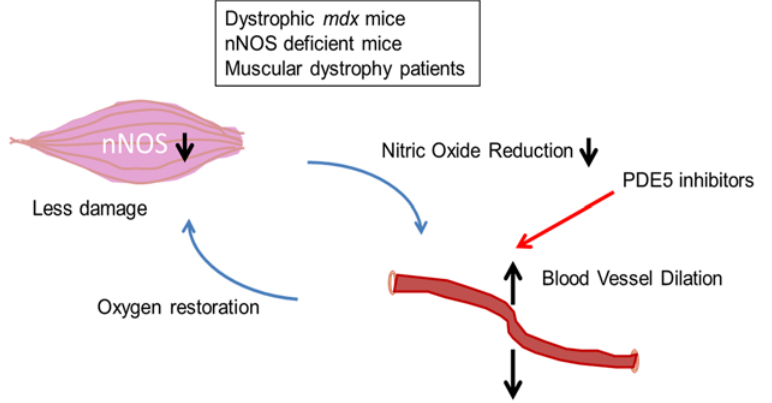
Figure 4. The two-hit hypothesis (two-hit theory) for myofiber damage and the effects of the functional ischemia on muscular dystrophy and animal models. The functional ischemia is caused by reduced nitric oxide (NO). The oxygen deficit leads to greater cellular susceptibility to metabolic stress and myofiber damage observed in muscular dystrophy (e.g., dystrophinopathies, and possibly sarcoglycanopathies and dystroglycanopathies). Phosphodiesterase type 5 (PDE5) inhibitors, such as tadalafil (cialis ® ) or sildenafil citrate (viagra ® ), inhibit the degradation of cGMP, increasing nNOS-mediated blood flow. Nelson et al . examined the effects of single oral doses of tadalafil or sildenafil on exercise-induced attenuation of reflex sympathetic vasoconstriction, a protective mechanism that promotes oxygen delivery to skeletal muscle [37] (Figure 5). PDE5 inhibition with standard clinical doses of either tadalafil or sildenafil alleviated the exercise-induced ischemia in DMD boys in a dose-dependent manner. In addition, PDE5 inhibitors normalized the exercise-induced increase in skeletal muscle blood flow. Tadalafil also alleviates muscle ischemia in patients with Becker muscular dystrophy [38]. These studies provide in-human proof of concept for PDE5 inhibition as a putative new therapeutic strategy for DMD, that is worthy of continued study.